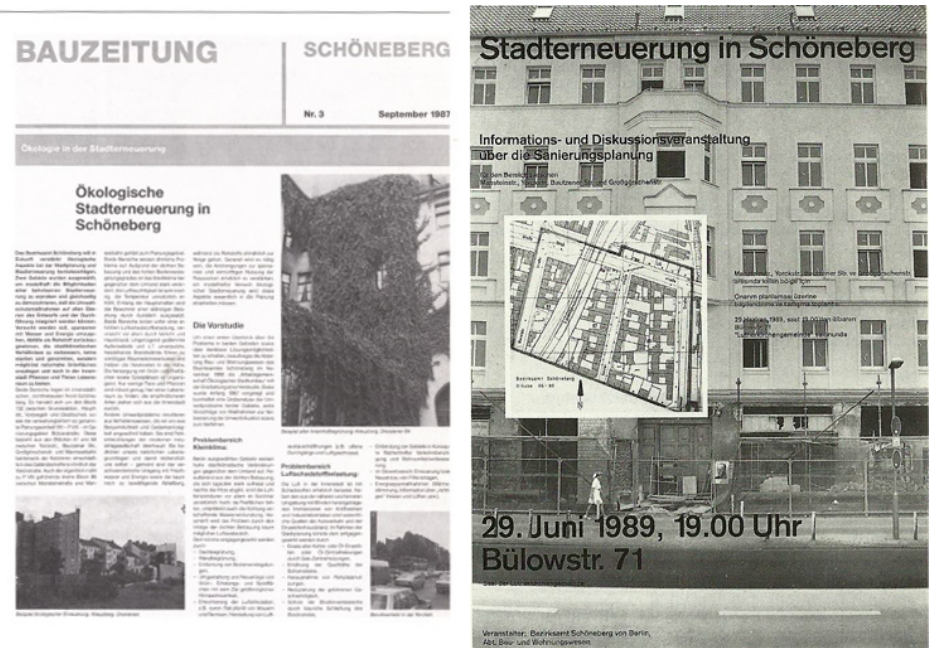
Figure 5. From left to right: Newspaper article about sustainable urban renewal within the redevelopment area and invi- tation leaflet for the second consideration meeting. Source: Bezirksamt Schöneberg (1992). ducted surveys through sending questionnaires, which were distributed to the households as well as on-site vis- its with inhabitants. Within this particular format of pub-